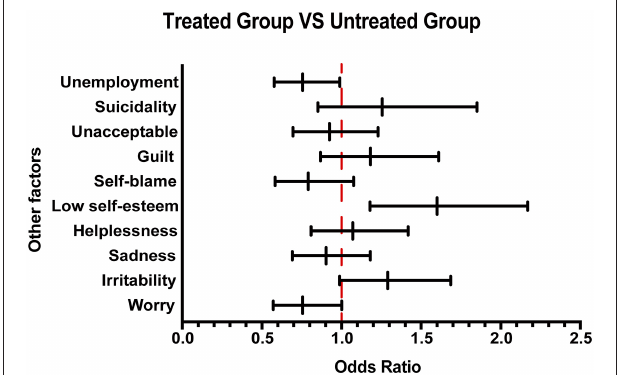
FIGURE 2 | Other emotional and employment factors differing between the treated and the untreated groups. The forest plot shows odds ratio differences in other factors between the treated and untreated